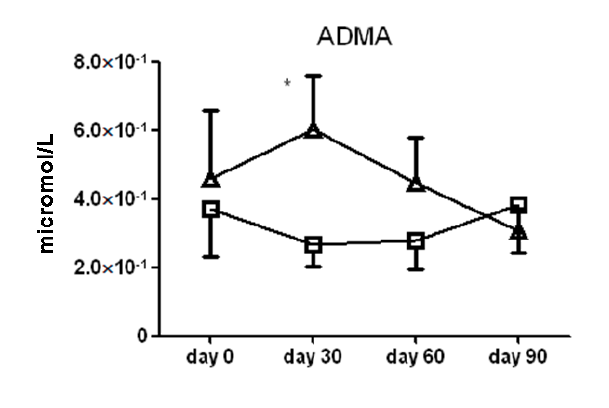
Figure 7. Serum asymmetric dimethyl arginine (ADMA) content from subjects treated with L -arginine (triangles) or placebo (squares). Mean ± SEM. * denotes p <